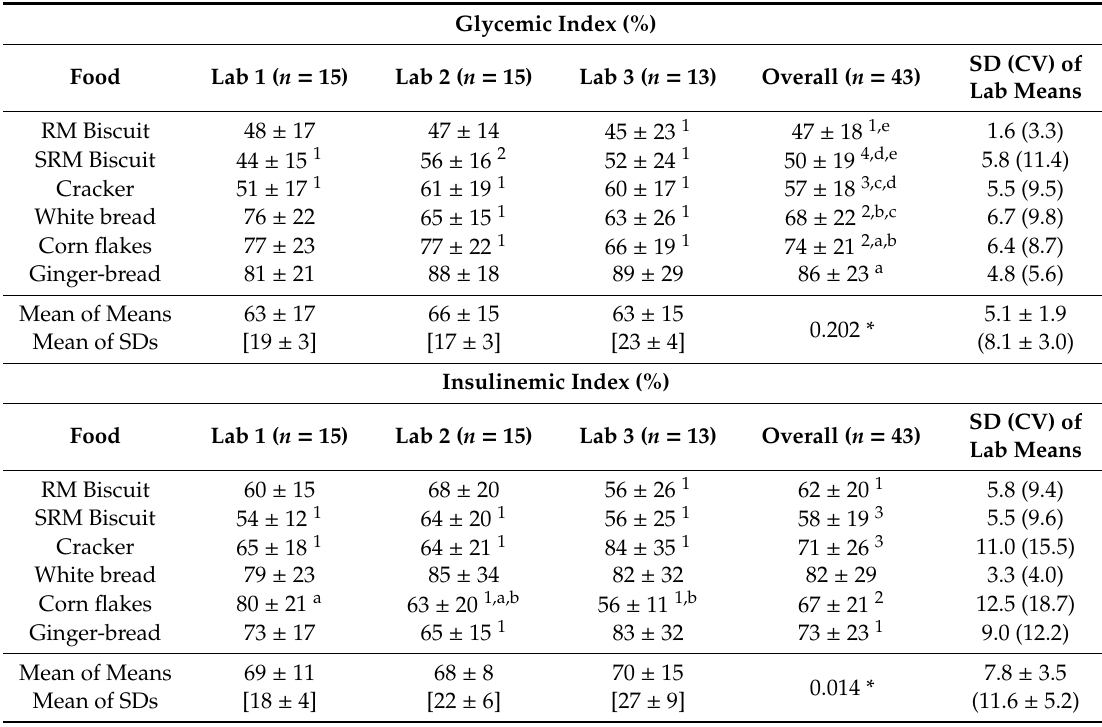
Table 3. GI and II values of the study products as determined in each